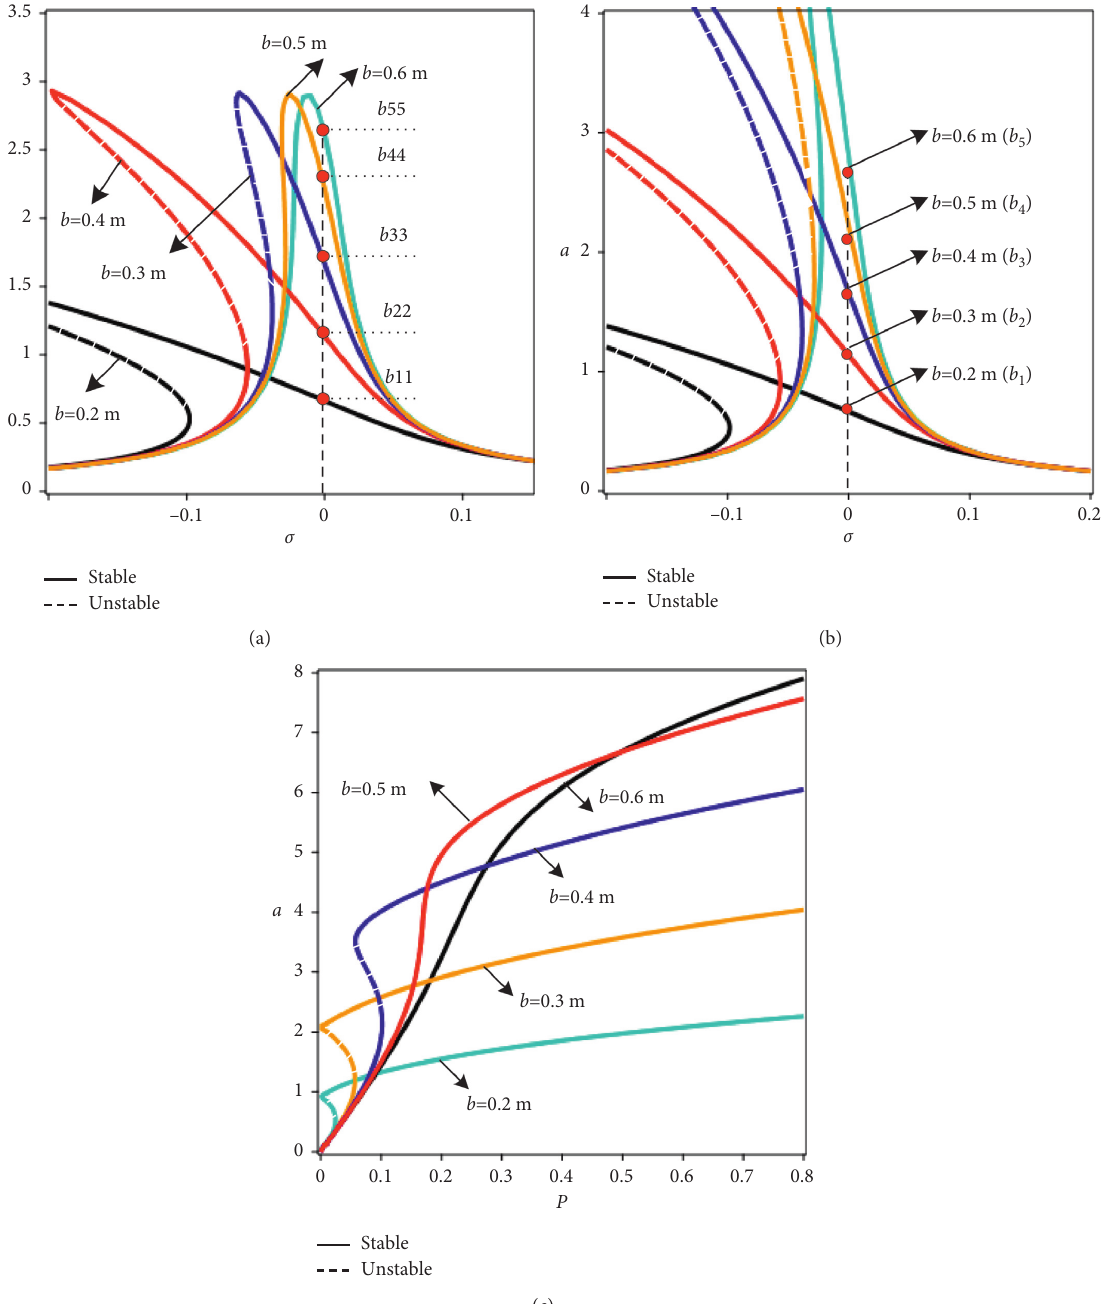
Figure 5: The amplitude-frequency response curve of primary resonance (varied b) (a) considering aerodynamic force; (b) without considering aerodynamic force; (c) with different excitation amplitudes ( σ �−